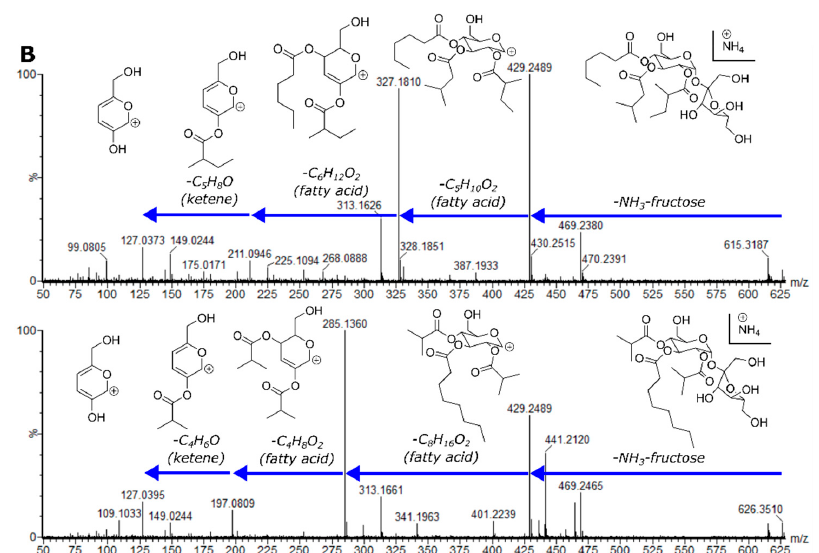
Figure 3. CID mass spectra of acylsugar structural isomers in positive-ion mode. ( A ) Mass spectra of S3:19(4,5,10)-1 (top) and S3:19(4,5,10)-2 (bottom). Structures of both compounds were resolved by NMR (Figure 4). ( B ) Mass spectra of S3:16(5,5,6) (top) and S3:16(4,4,8) (bottom). Structures of these compounds were not resolved by NMR, and the specific branching patterns and positions of acyl chains are unknown.